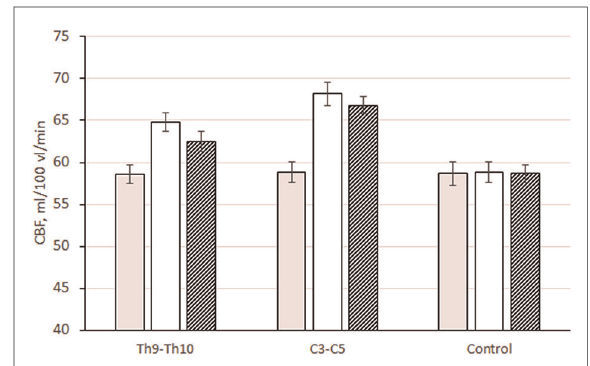
FIGURE 3 Changes in CBF (ml/100 ml/min) in the cerebral cortex (on average for all departments) in patients with epidural electrode placement at different levels: Th9 – Th10, 1 subgroup; C3 – C5, 2 subgroups; control, control